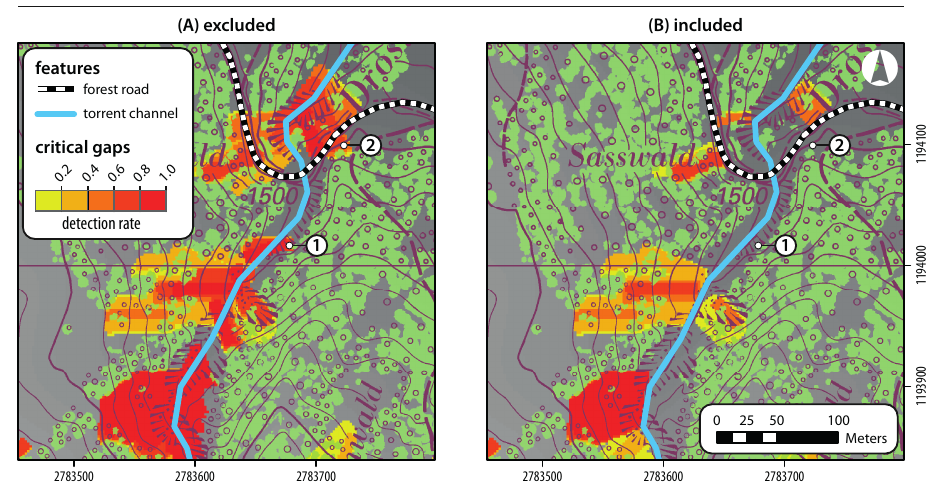
Figure 9. Comparison of detected critical gaps when ( A ) excluding and ( B ) including linear features that decouple hillslopes. The channel was digitized from the topographic map: Uebersichtsplan (UP), Canton of Grisons, 17 January